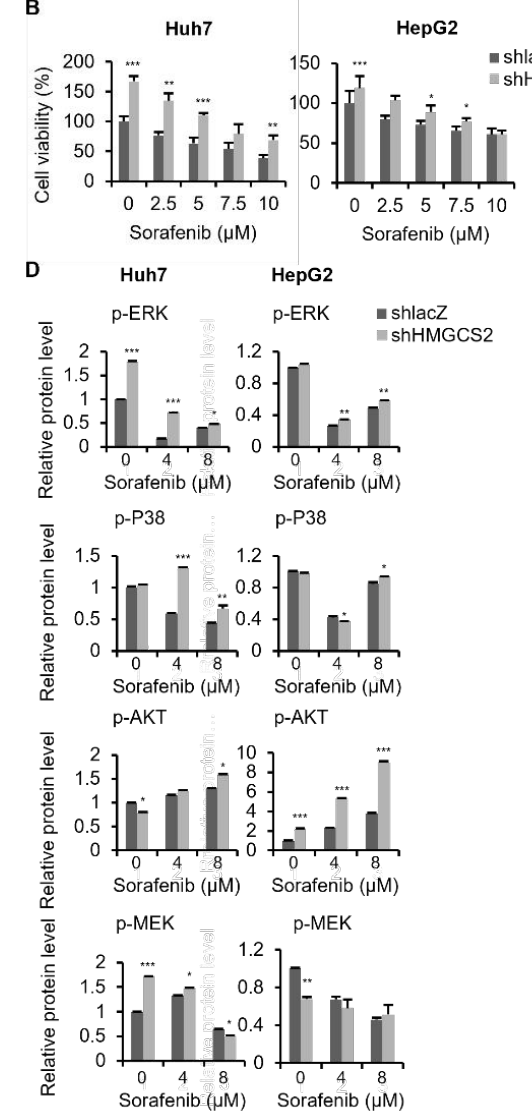
Figure 1. Knockdown of the HMGCS2 gene increased cell proliferation and decreased sorafenib sensitivity through promoting the mitogen-activated protein kinase (MAPK) and Akt signaling pathway in Huh7 and HepG2 cells. ( A ) Western blot analysis of HMGCS2 knockdown in Huh7 and HepG2 cells. ( B ) shlacZ control and HMGCS2-knockdown Huh7 and HepG2 cells were treated with 0, 2.5, 5, 7.5, and 10 µ M sorafenib for 48 h, and an MTT assay was conducted to detect cell viability. ( C ) shlacZ control and HMGCS2-knockdown cells were treated with sorafenib (0, 4, and 8 µ M) for 48 h. phosphorylated (p)- and total (t)- MAPK- and AKT-related signaling cascades were evaluated by Western blotting. α -Tubulin was used as an internal control. The representative data are obtained from three independent experiments. ( D ) Western blot images from Figure 1C were quantified by using the ImageJ software. * p < 0.05; ** p < 0.01; *** p < 0.001 vs. the shlacZ control. Data are shown as the mean ±